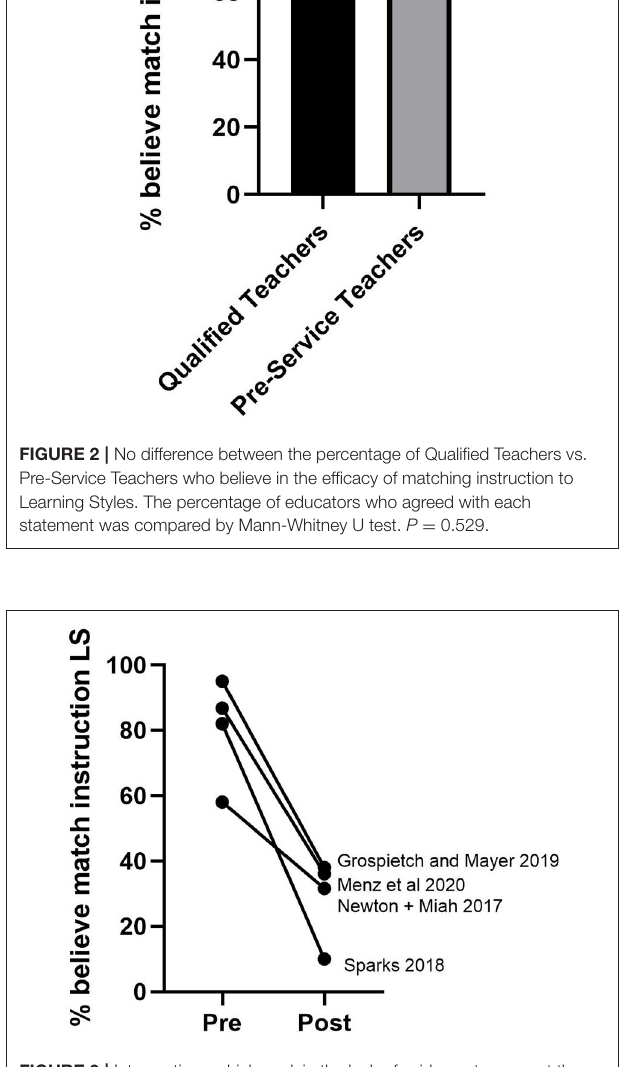
FIGURE 3 | Interventions which explain the lack of evidence to support the efficacy of matching instruction to Learning Styles are associated with a drop in the percentage of participants who report agreeing that matching is effective. Each of the four studies used a pre-post design to measure self-reported belief. The weighted percentage dropped from 78.4 to